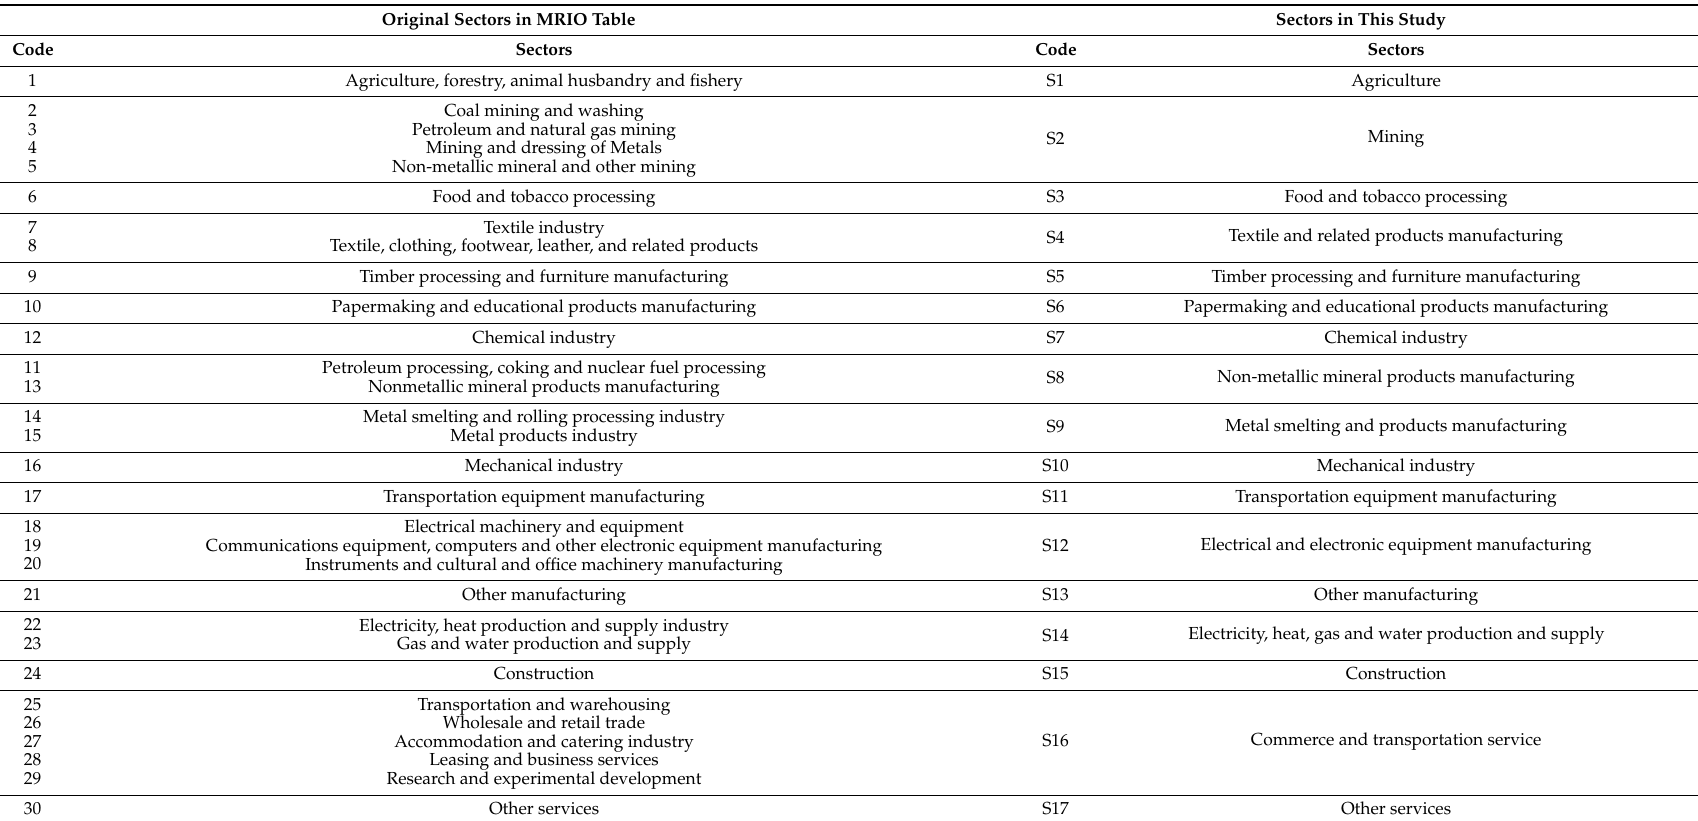
Table A2. Sectors aggregation in this